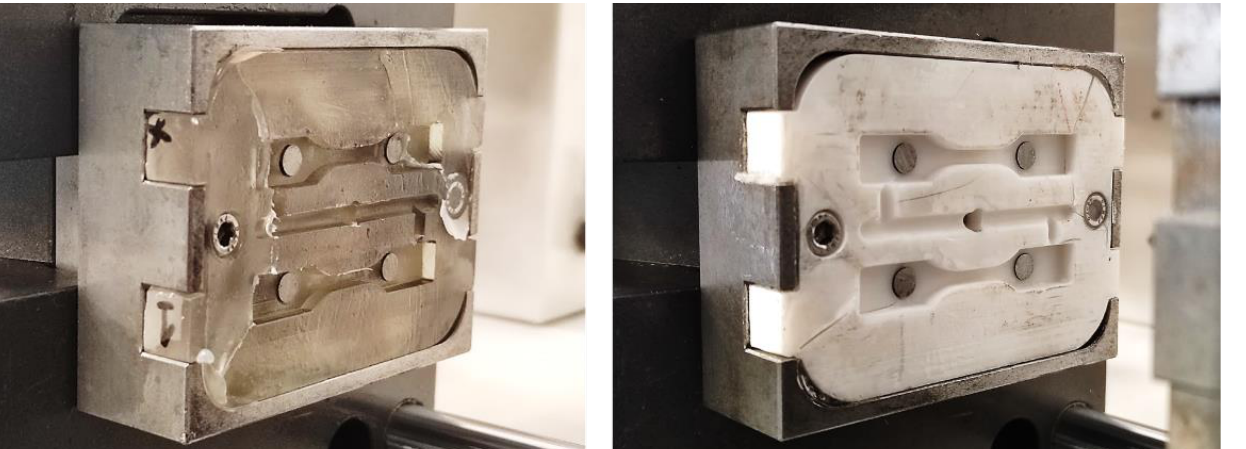
Figure 6. Storage modulus (continuous line) and tan(δ) (dashed line) for HighTemp (blue) and Rigid 10k (red) insert materials. At the maximum cavity temperatures recorded with the IR thermal camera during the moulding cycles for HighTemp and Rigid 10k insert materials, respectively 75.1 and 56.4 °C, E’ exhibited values of 479.2 and 4495.8 MPa, representing a nearly ten-times dif- ference. In addition, the E’ values are validated by the analogo us Young’s modulus [21,22]. T g also presented a sharp difference between the insert materials, being ca. 45 °C higher for the glass fibre-containing resin. Rigid 10k resin presented a secondary T g at 93.7 °C, which suggests that the polymeric fraction of the material actually consists of a blend of two different photopolymer resins. Zhao et al. (2015) studied mixtures of acrylate- and epoxy-based photopolymerisable resins for SLA and demonstrated the occurrence of two separate T g ’s for a single blend, each one associated with one of the UV -sensitive mono- mers [30].